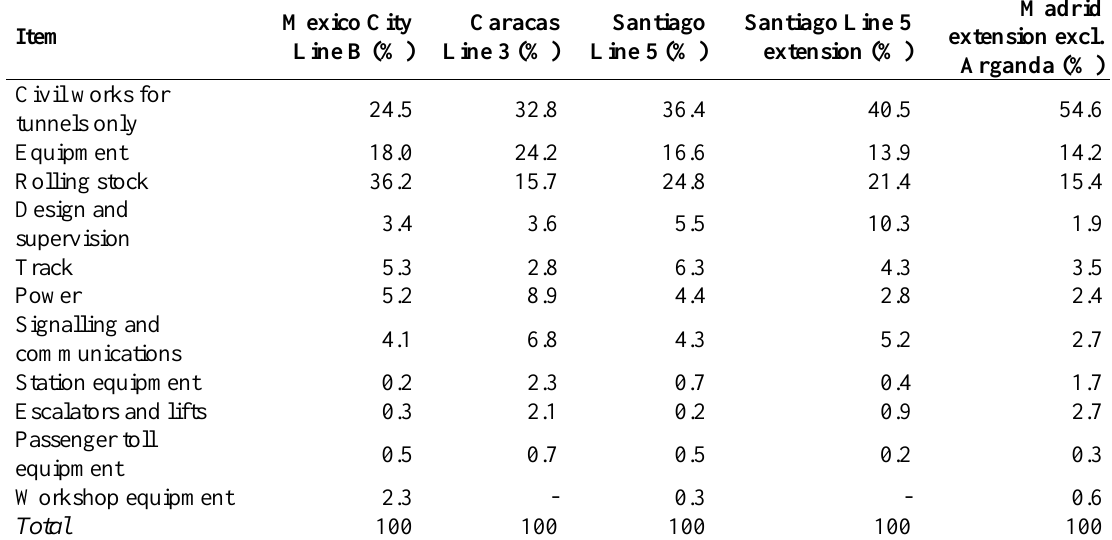
Table 8. Breakdown of metro capital costs by item for five metro extensions in Madrid, Caracas, Mexico City and